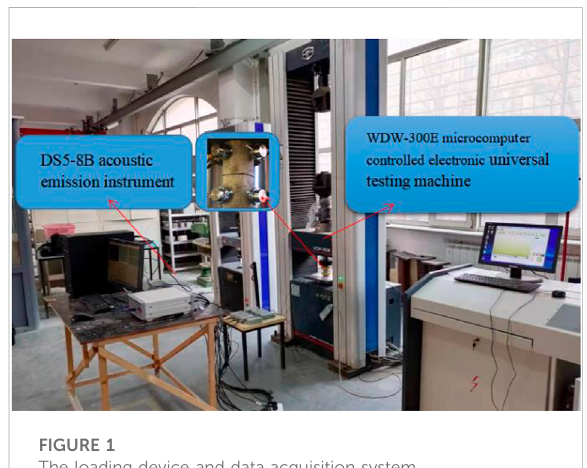
FIGURE 1 The loading device and data acquisition